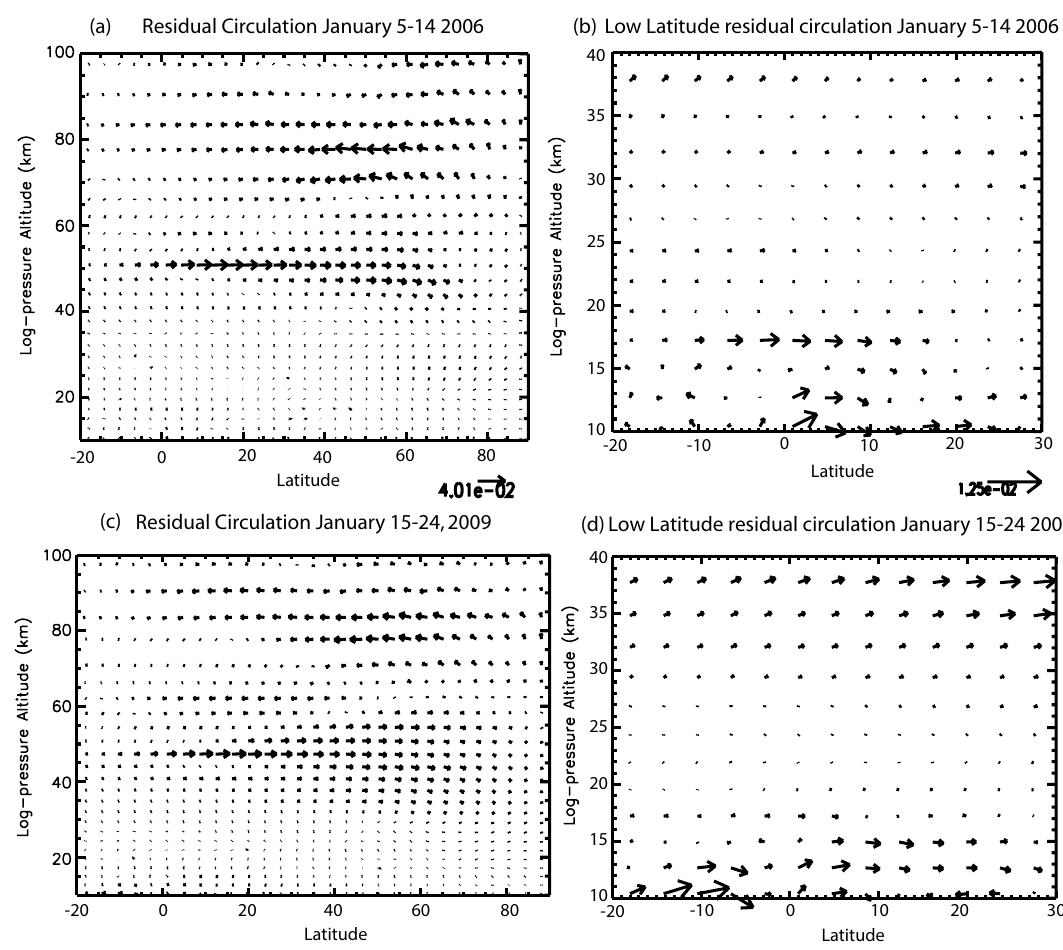
Figure 7. Plot of residual circulation vectors (a) between 10 and 100km and 20 ◦ S to 90 ◦ N averaged over 5–14 January 2006, (b) between 10 and 40km and 20 ◦ S to 30 ◦ N averaged over 5–14 January 2006, (c) between 10 and 100km and 20 ◦ S to 90 ◦ N averaged over 15– 24 January 2009 and (d) between 20 and 50km and 20 ◦ S to 30 ◦ N averaged over 15–24 January